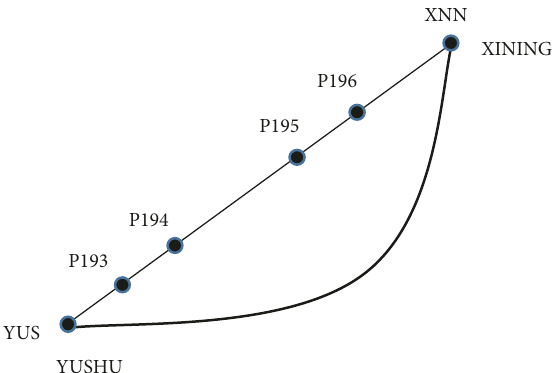
Figure 3: Relationship between a certain route and airway network.